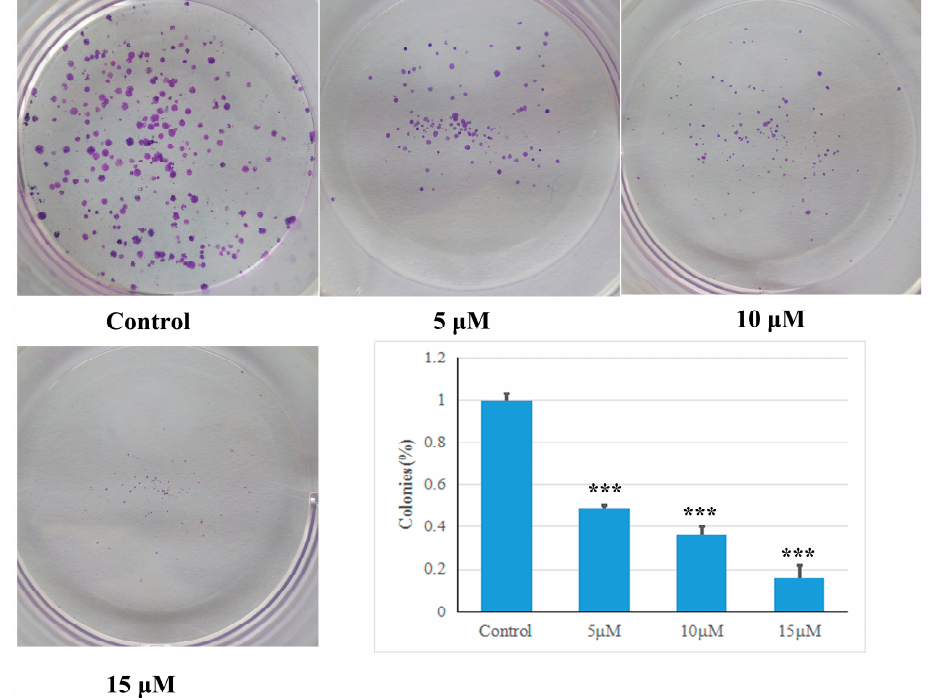
Figure 3. The colony formation of HCT-116 cells after treatment with different concentration (5, 10 and 15 µ M) of compound 5d for 7 days; The rate of inhibition induced by compound 5d was expressed as the mean ± SD of three independent experiments, *** p < 0.001 vs control group (untreated cells); The clonogenicity assay was quantified using Image J software.